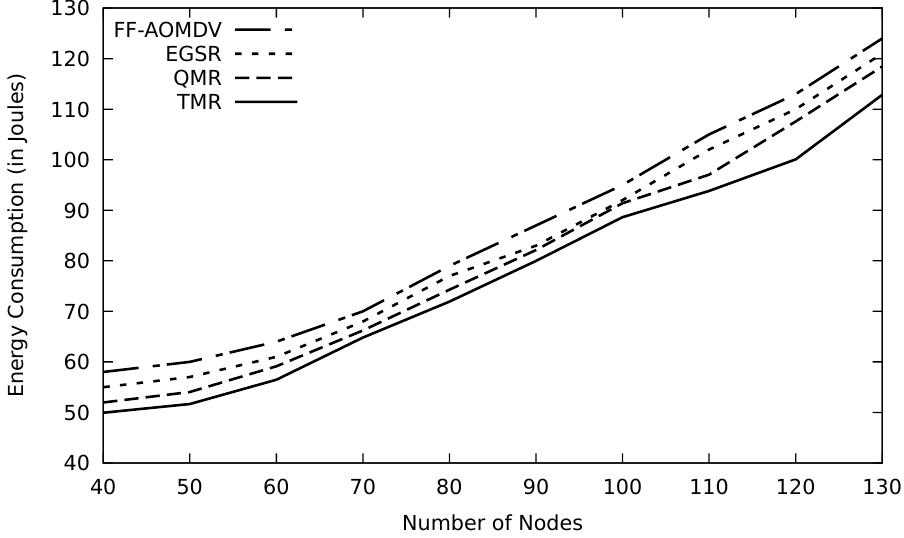
Figure 17. Comparison of FF-AOMDV, EGSR, QMR, and proposed protocol TMR for energy con- sumption with number of